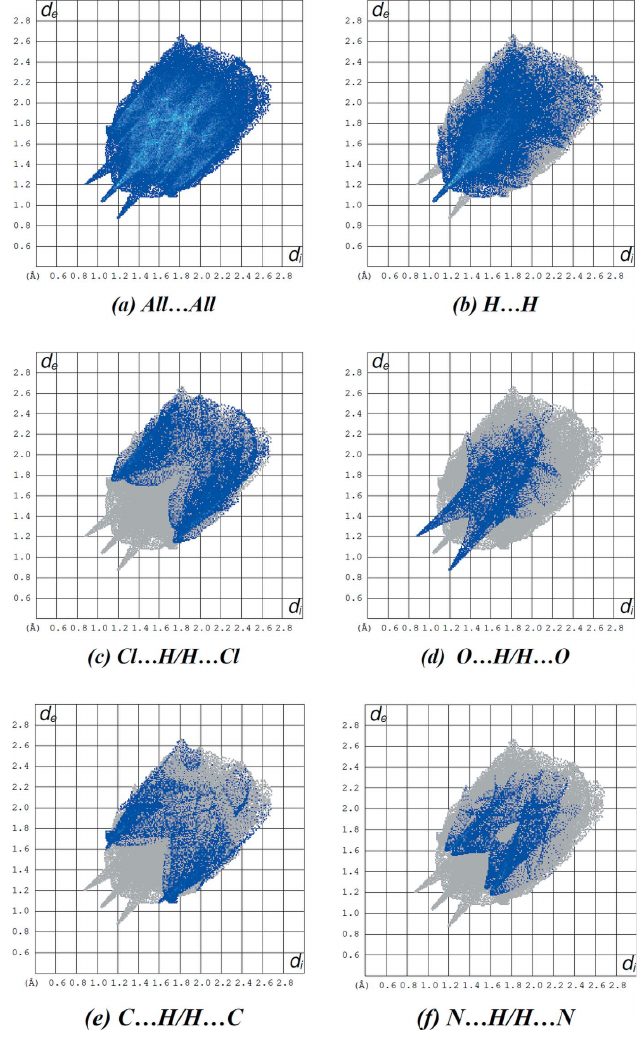
Figure 5 A view of the two-dimensional fingerprint plots for the title compound, showing ( a ) all interactions, and delineated into ( b ) H (cid:2)(cid:2)(cid:2) H, ( c ) Cl (cid:2)(cid:2)(cid:2) H/ H (cid:2)(cid:2)(cid:2) Cl, ( d ) O (cid:2)(cid:2)(cid:2) H/H (cid:2)(cid:2)(cid:2) O, ( e ) C (cid:2)(cid:2)(cid:2) H/H (cid:2)(cid:2)(cid:2) C and ( f ) N (cid:2)(cid:2)(cid:2) H/H (cid:2)(cid:2)(cid:2) N interactions. The d i and d e values are the closest internal and external distances (in A˚ ) from given points on the Hirshfeld surface.